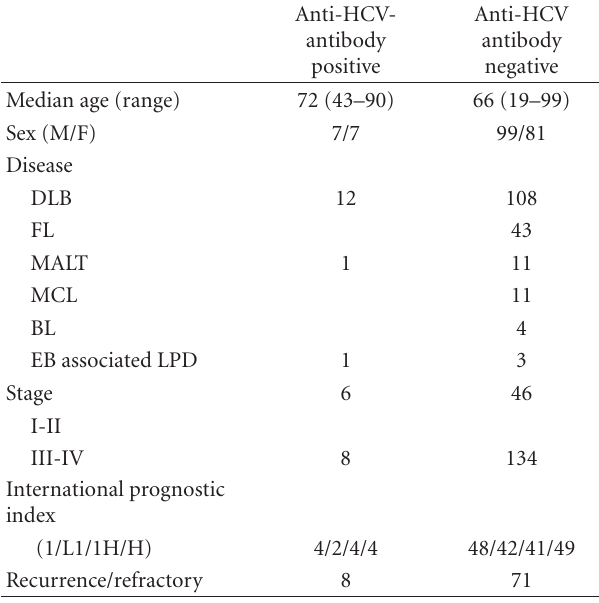
Table 1: Characteristics of the